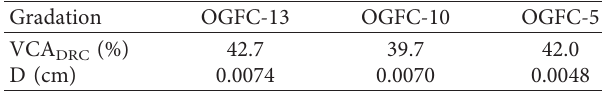
Figure 6: Voids ratio and connected voids ratio of different nominal maximum aggregate sizes. Table 6: The framework voids width of the